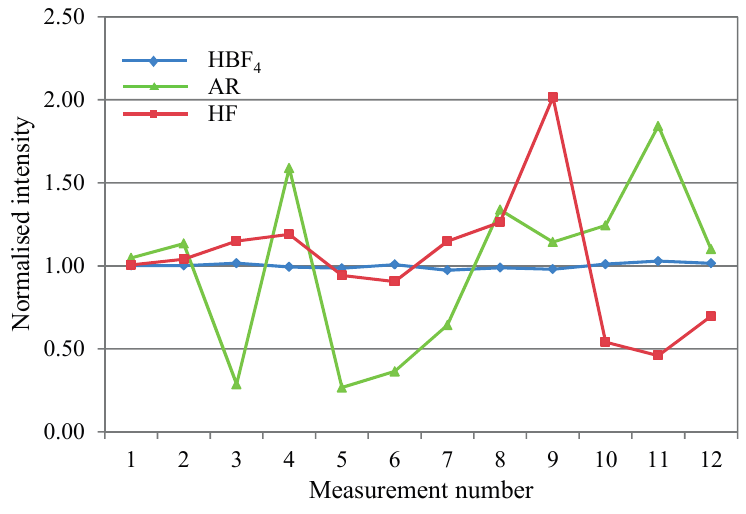
Figure 3. Arsenic drift plot, showing severe drift in both the AR matrix (from the [ArCl] + interference) and the standard HF matrix.